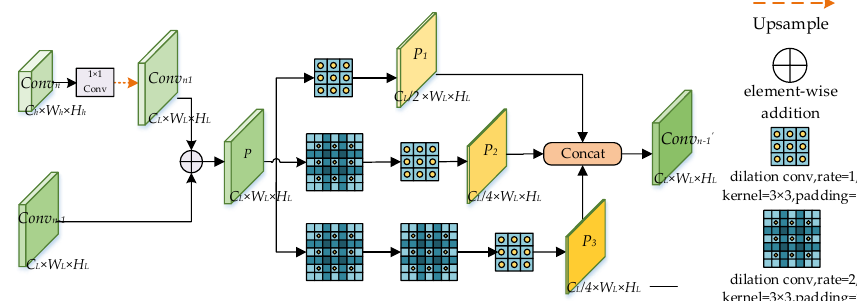
Figure 3. Feature enhancement fusion network.